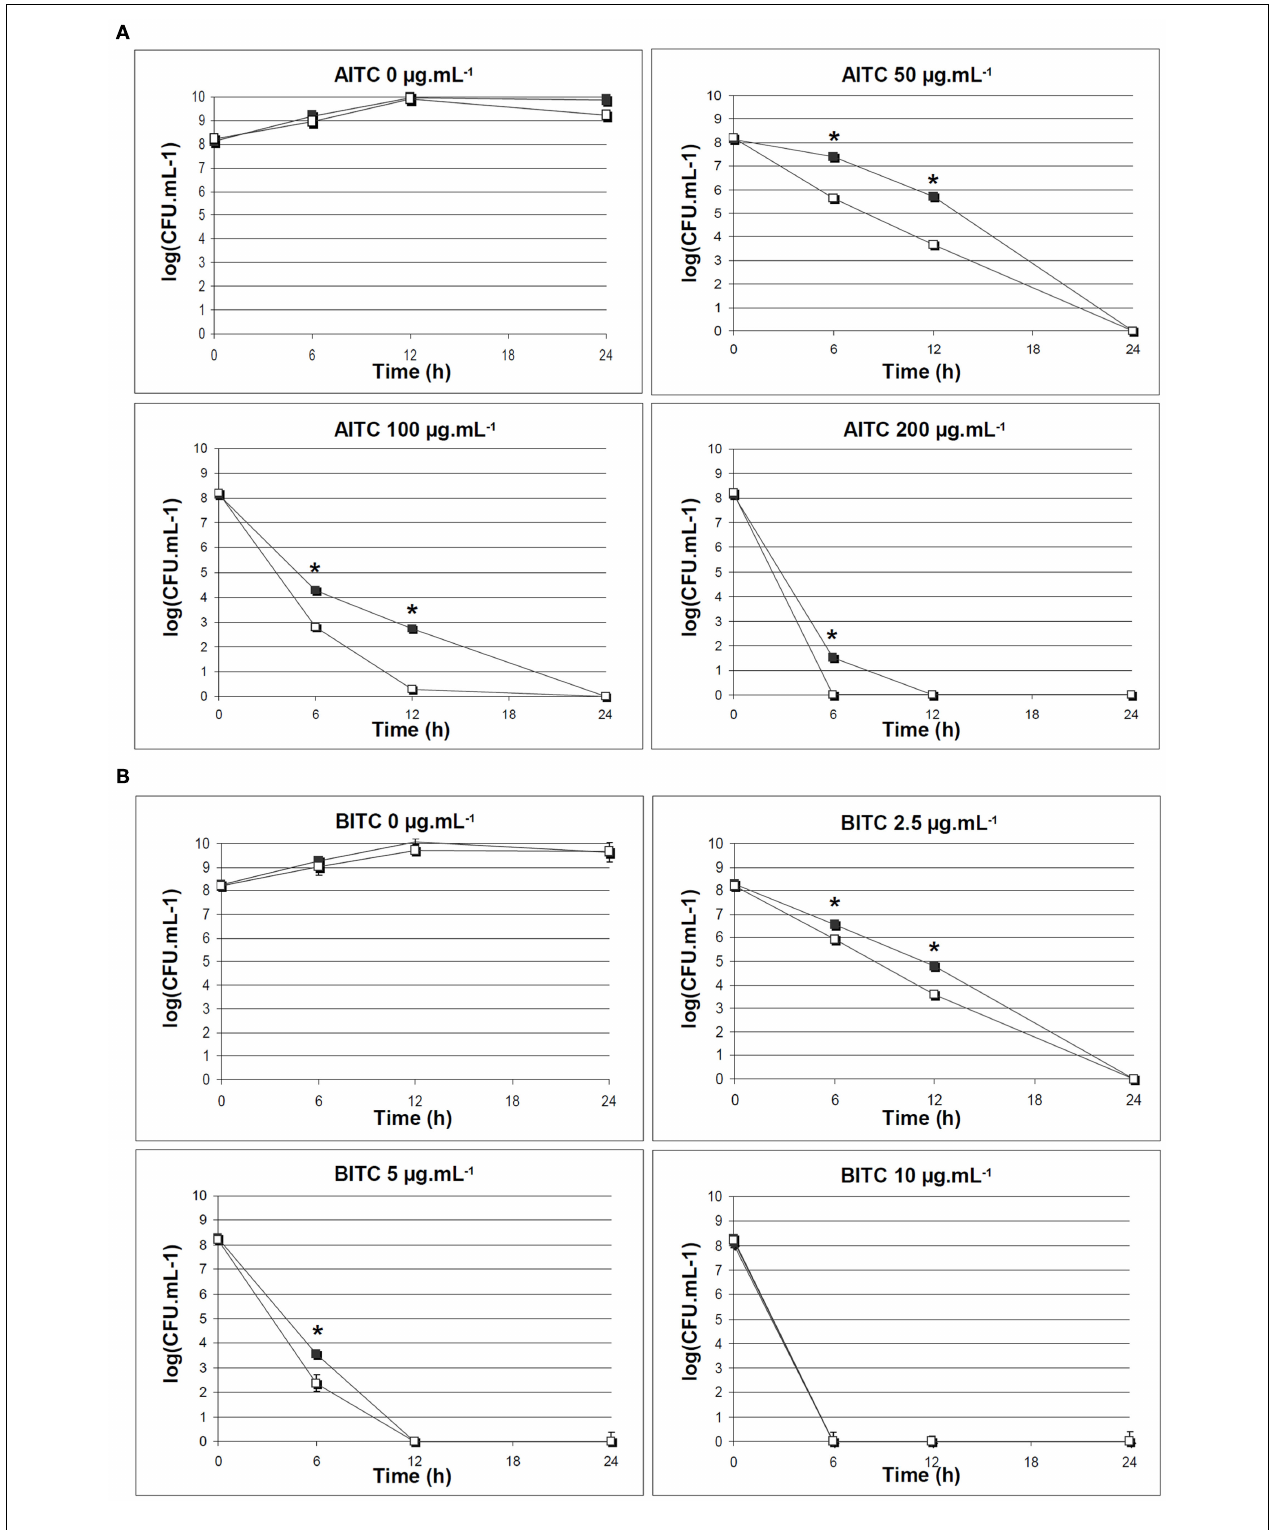
FIGURE 3 | Survival rate of C. jejuni 81-176WT and ggt mutant exposed toAITC or BITC. C. jejuni strains were grown in MH Broth at 37˚C in microaerobic conditions and viable cells were numbered after 6, 12, or 24h-exposure to ITC. Black squares: C. jejuni 81-176WT; white squares: